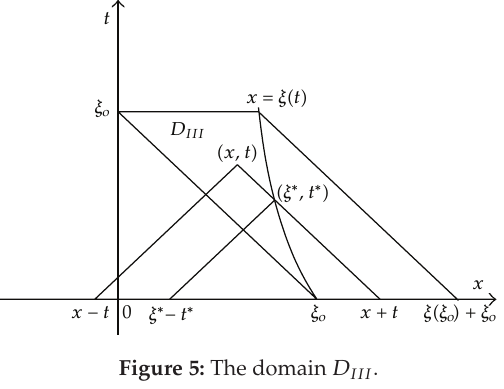
Figure 5: The domain D III